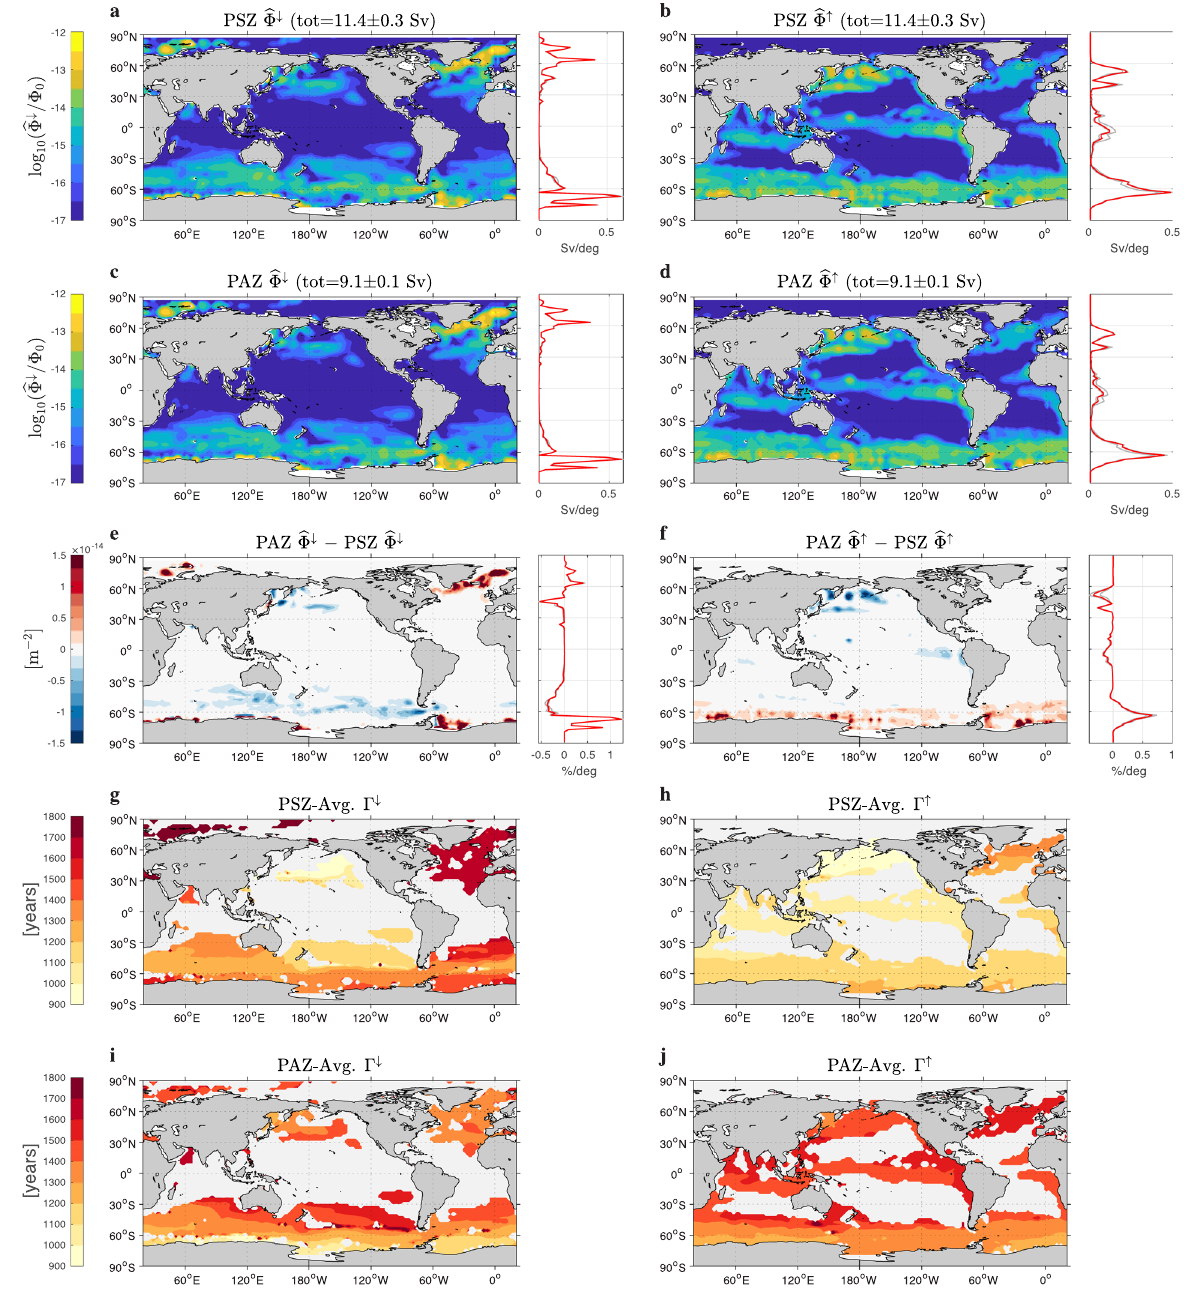
# from the surface to the Paci fi c " from the PSZ to the surface ( b )